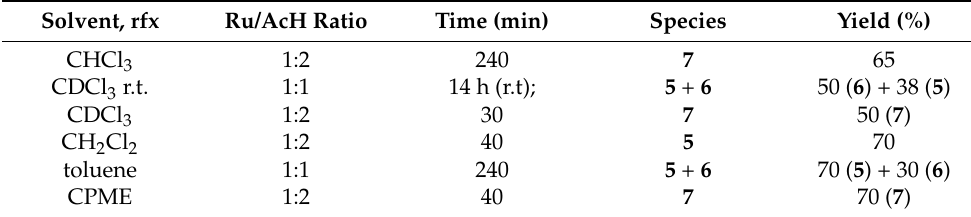
Table 1. Selected conditions for the reaction of 1 with